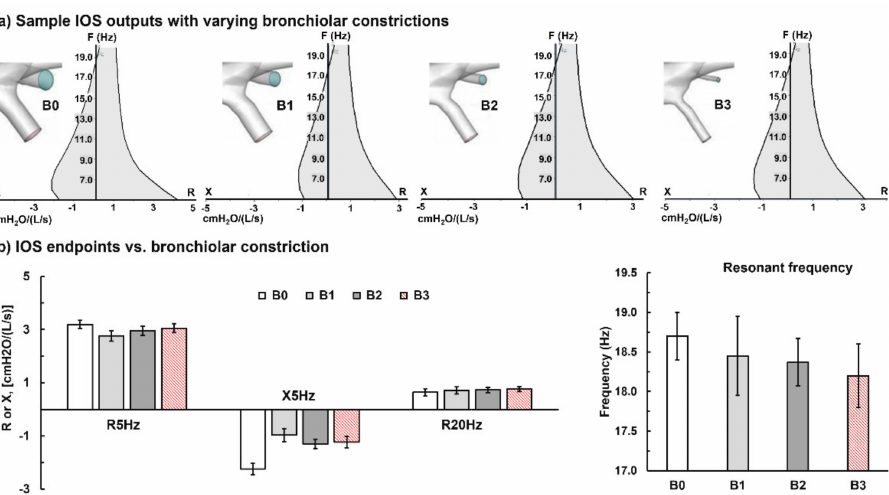
Figure 3. IOS characterization of the mouth–lung (G6) models with varying bronchial constriction levels in the left upper lobe; ( a ) sample IOS outputs for the models B0 (no constriction), B1 (mild constriction), B2 (moderate constriction), and B3 (severe constriction), and ( b ) comparison of ISO endpoints (R5Hz, X5Hz, R20Hz, and resonant frequency) among the four models B0–3. The variables in ( a ) are the resistance R (cmH 2 O/(L/s)) in the positive x -axis, reactance X (cmH 2 O/(L/s)) in the negative x -axis, and frequency (Hz) in the y